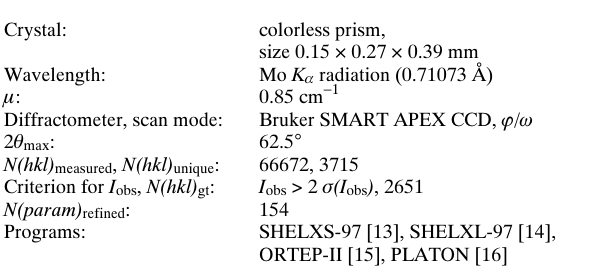
Table 1. Data collection and